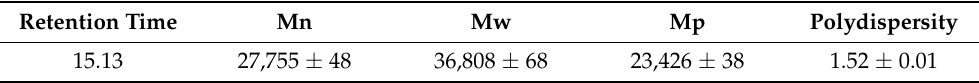
Table 2. GPC results of ZnO-PLLA .